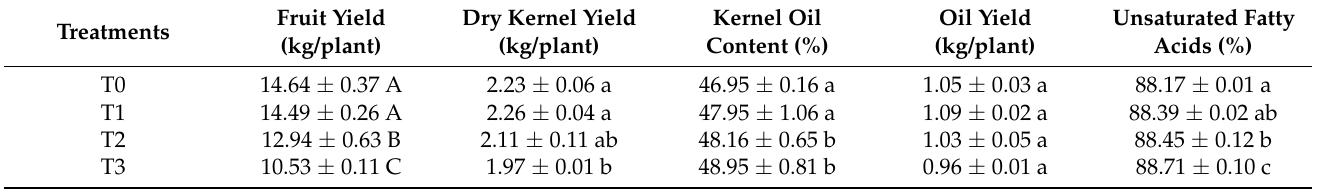
Table 3. Fruit economic index at mature stage of different flower loads per plant